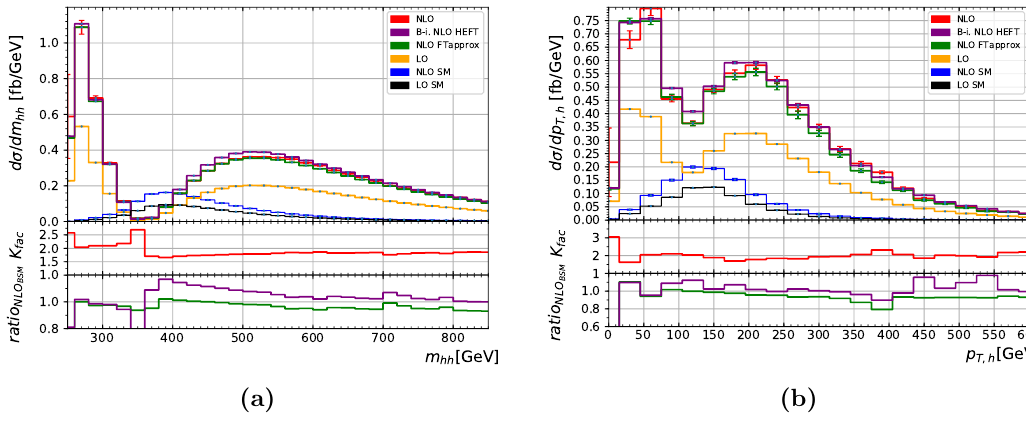
Figure 12. Higgs boson pair invariant mass distribution and transverse momentum distribution of one of the Higgs bosons for benchmark point 1, c hhh = 7 : 5 ; c t = 1 ; c tt = (cid:0) 1 ; c ggh = c gghh = 0. The ratio plot with the K-factor shows NLO BSM /LO BSM . The lower ratio plot shows the ratios (Born-improved NLO HEFT)/NLO BSM (purple) and FT approx /NLO BSM (green).